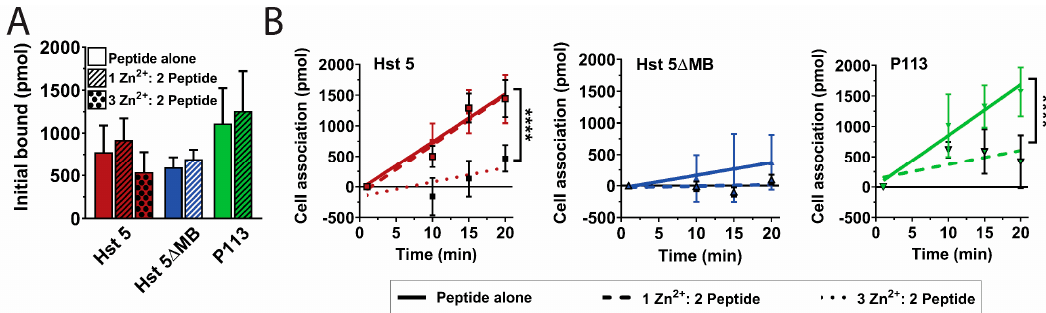
Figure 4. Zinc decreases uptake of P113 at a one Zn 2 + to two peptides ratio and Hst 5 at a three Zn 2 + to two peptides ratio. Cell association assays were performed at 30 ◦ C with 0.44 fmol / cell. Hst 5 (red), Hst 5 ∆ MB (blue), and P113 (green) in 10 mM sodium phosphate bu ff er pH 7.4 with or without added Zn 2 + at a one Zn 2 + to two peptides ratio (hatched) or a three Zn 2 + to two peptides ratio (dots). Time points were taken at 1, 10, 15, and 20 m. ( A ) One minute time points were taken as initial binding and ( B ) cell association attributed to active uptake was calculated by subtracting the initial time point from the 10, 15, and 20 m time points. Linear regressions were performed to determine rate of uptake. Experiments were repeated on at least three separate days and averaged. Significance of di ff erences in initial binding were calculated using one-way ANOVA with Sidak’s multiple comparisons test. Significance of di ff erences in rate of uptake were calculated using one-way ANOVA with Sidak’s multiple comparisons test. **** indicates p ≤ 0.0001